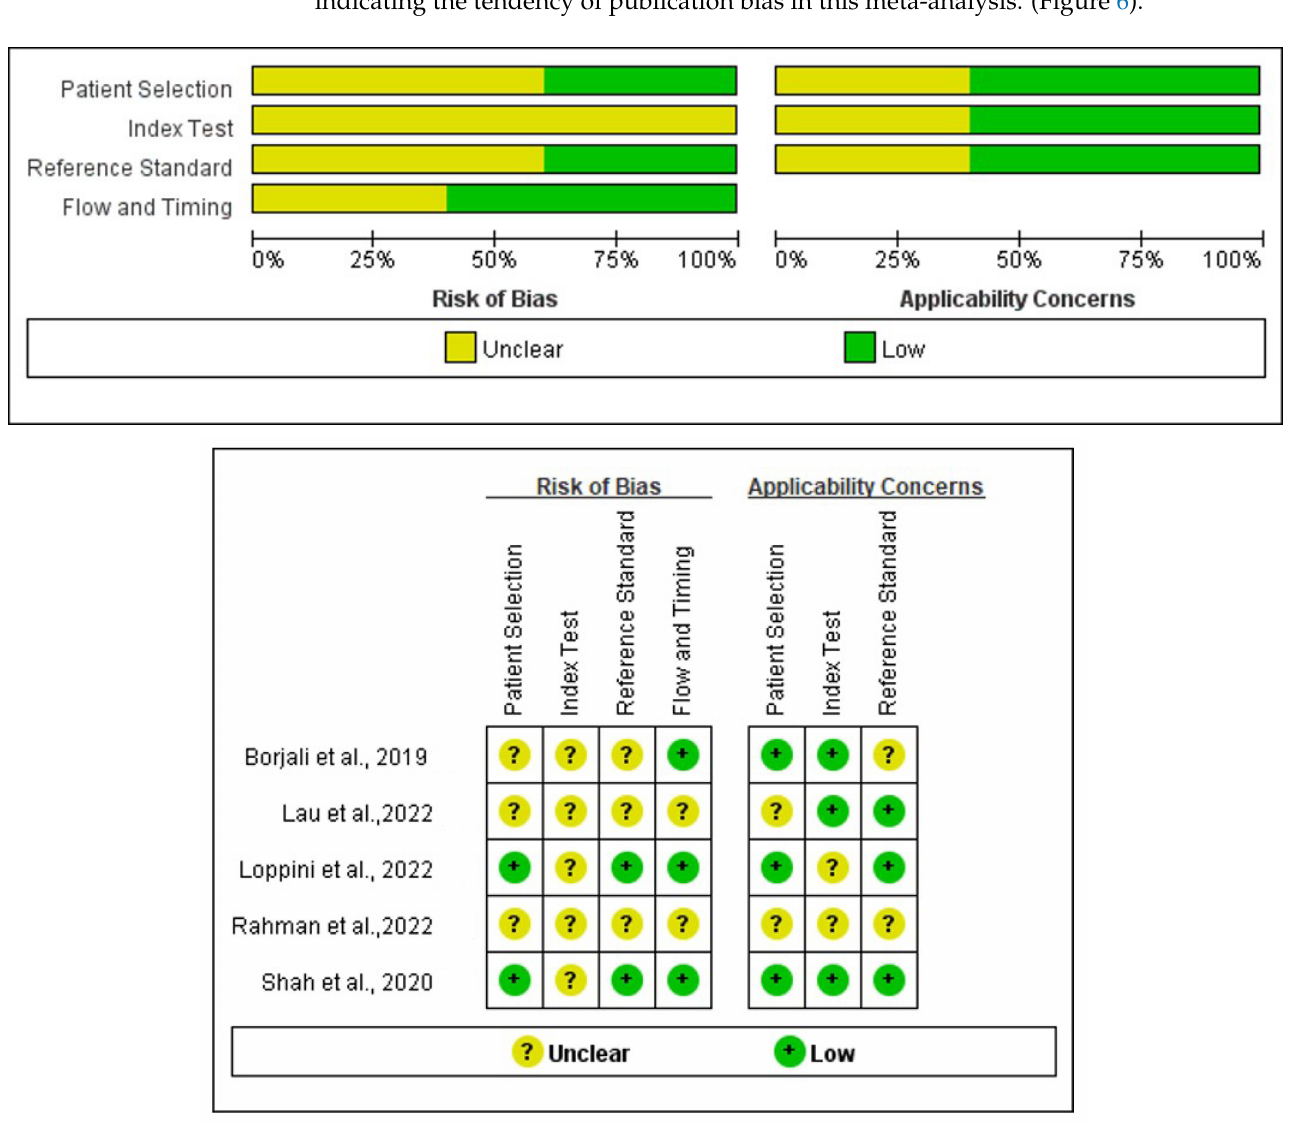
curve (AUC) = 0.985. SROC: summary receiver operating characteristics; SE: standard error; AUC: